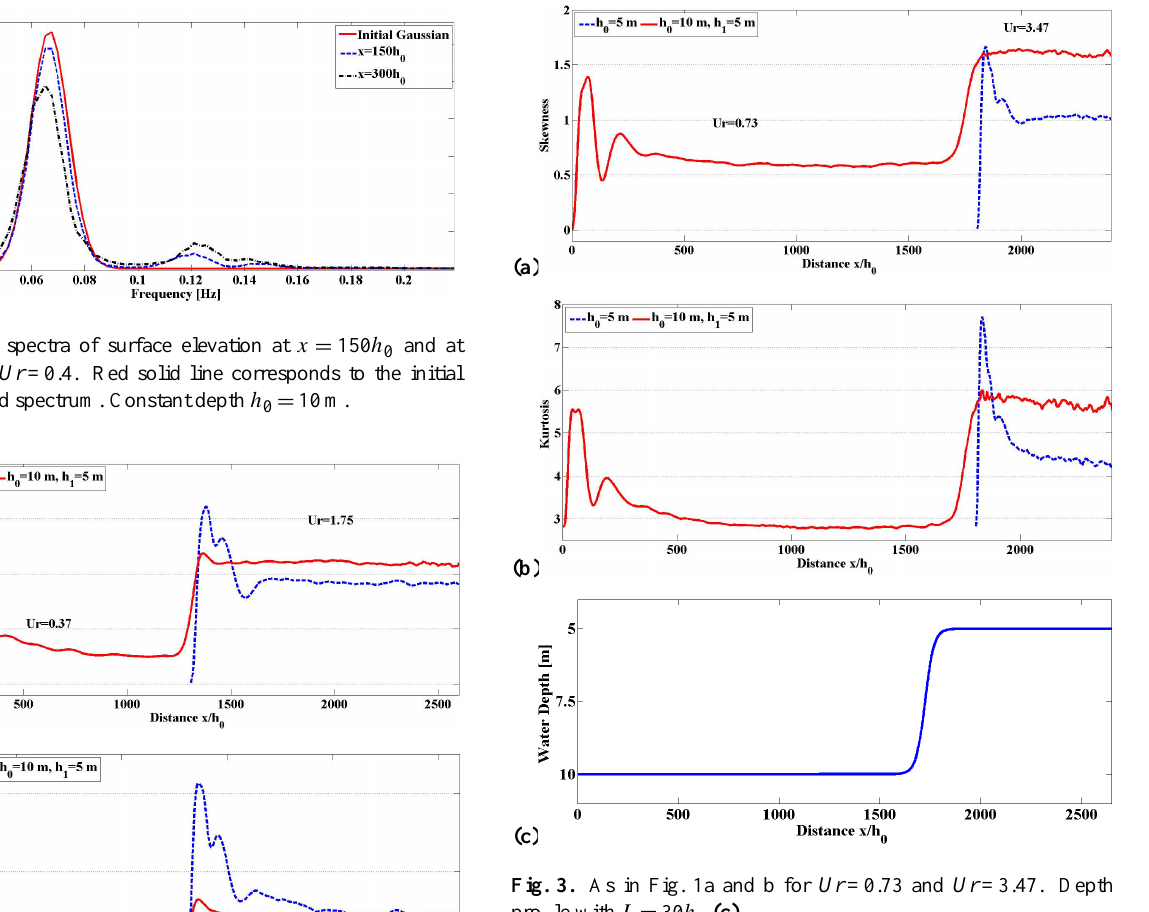
profile with L = 30 h 0 (c)